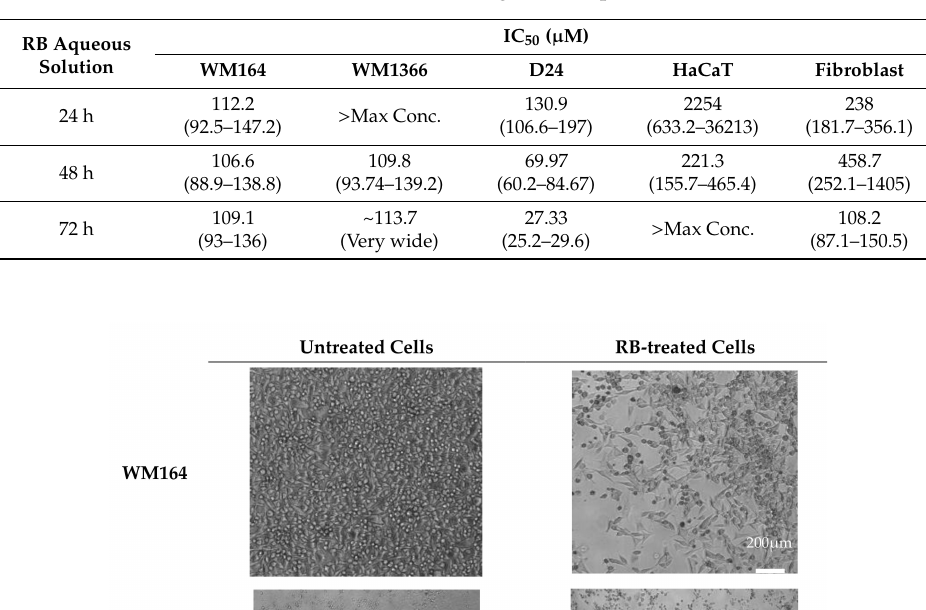
Table 2. IC 50 values of Rose Bengal (RB) aqueous solution.